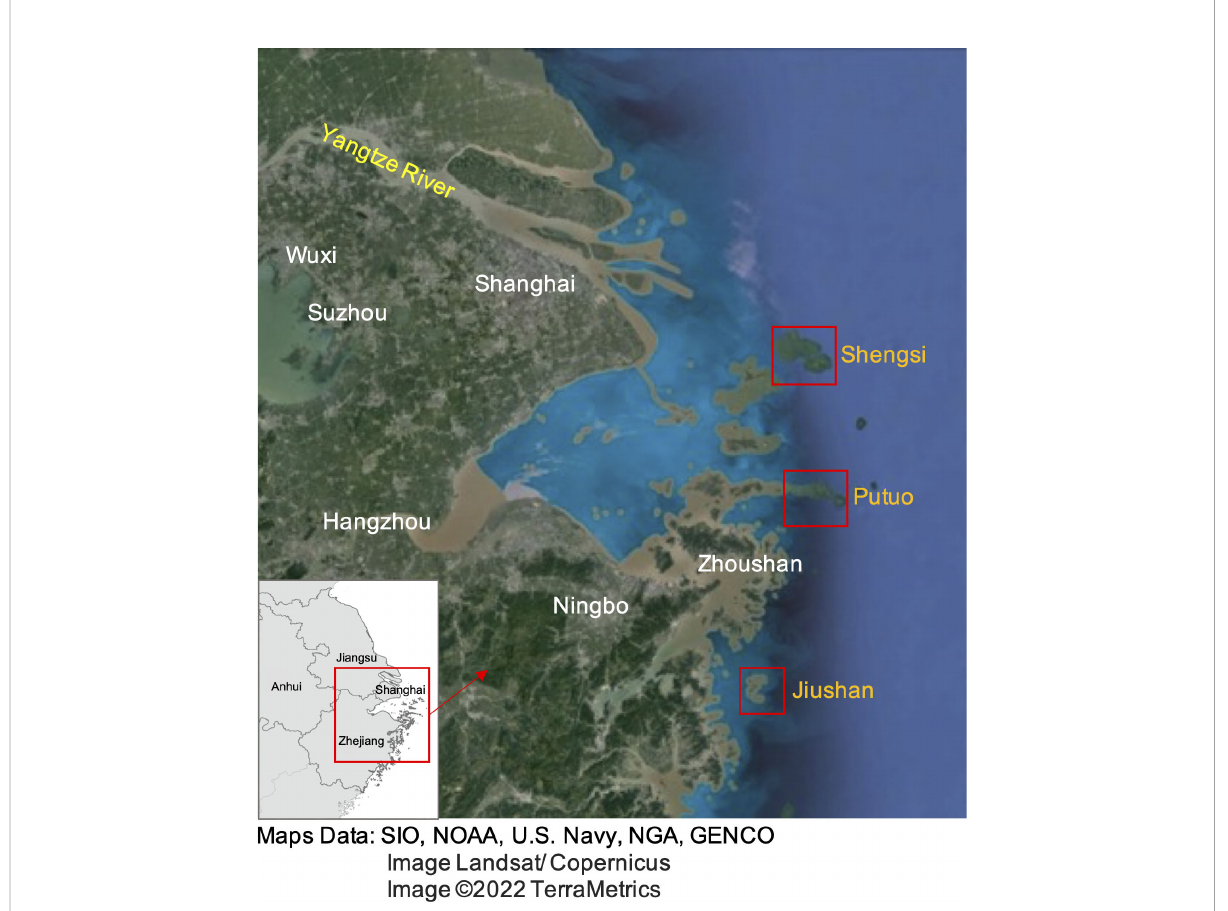
FIGURE 1 The Yangtze River Delta (in the bottom left corner, including Shanghai, Jiangsu, Anhui, Zhejiang) and the locations of Shengsi National Marine Park (Shengsi), Putuo National Marine Park (Putuo), and Jiushan Archipelago Marine Ecological National Nature Reserve